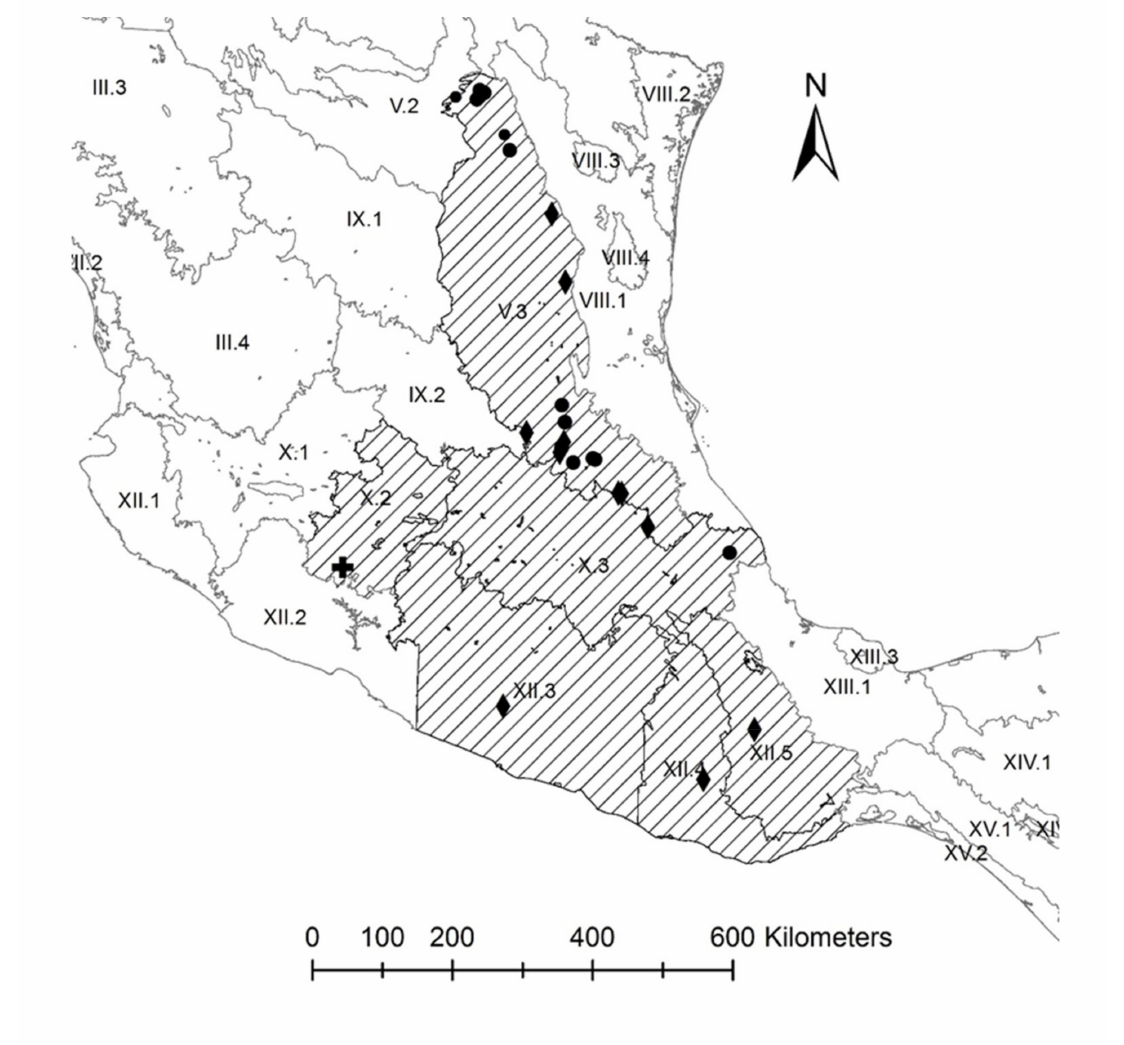
Figure 3. Populations and their genetic zones (striped polygons) considered as the most suitable source for providing forest reproductive material. Pinus greggi (black dots), P. oocarpa (black crosses) and P. patula (black